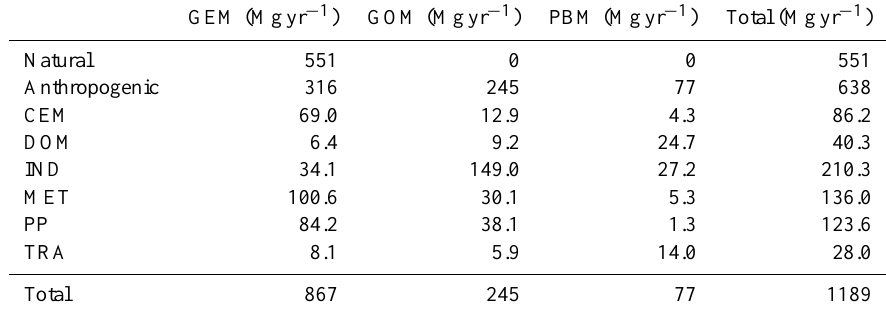
Table 1. Summary of mercury emissions in the model domain